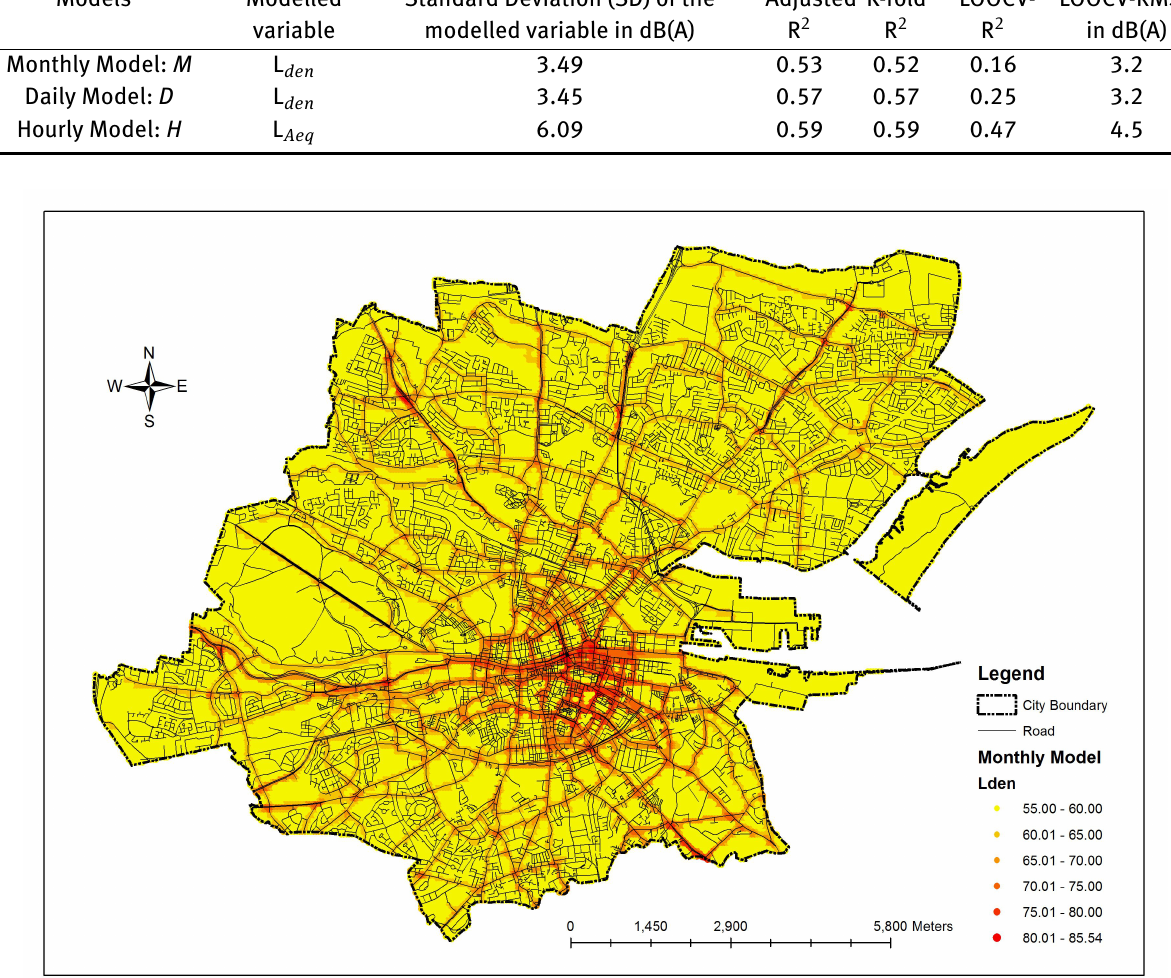
Figure 2: Map showing the spatial variation of L den , derived from Monthly M